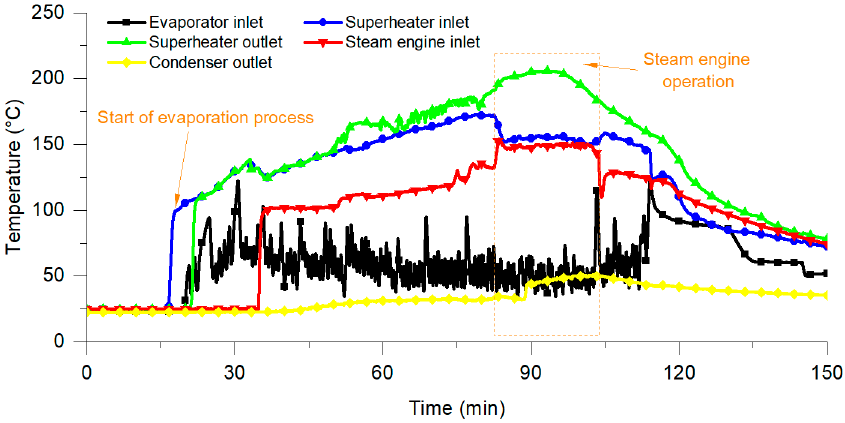
Figure 13. The variations in steam temperature in the steam-condensate circuit.